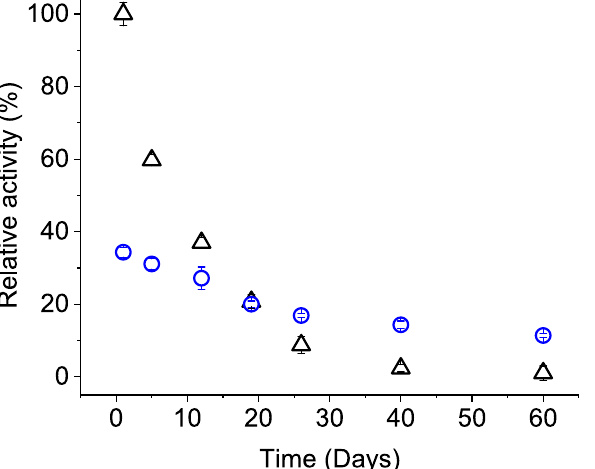
Figure 8. Change of tyrosinase ink (∆) and printed fabric (O) activity during storage